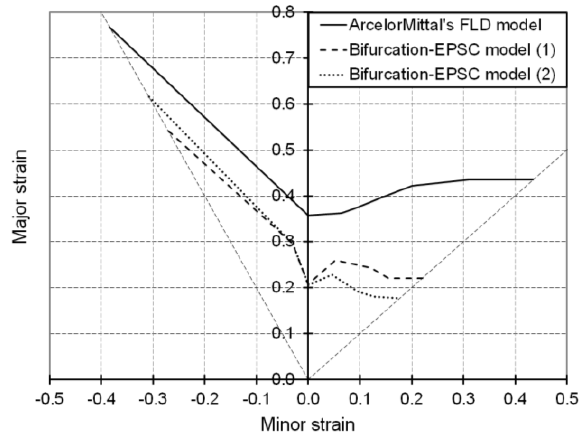
Figure 5. Simulated FLDs associated with linear strain paths for the IF–Ti single-phase steel as obtained with Bifurcation–EPSC and ArcelorMittal’s models. For